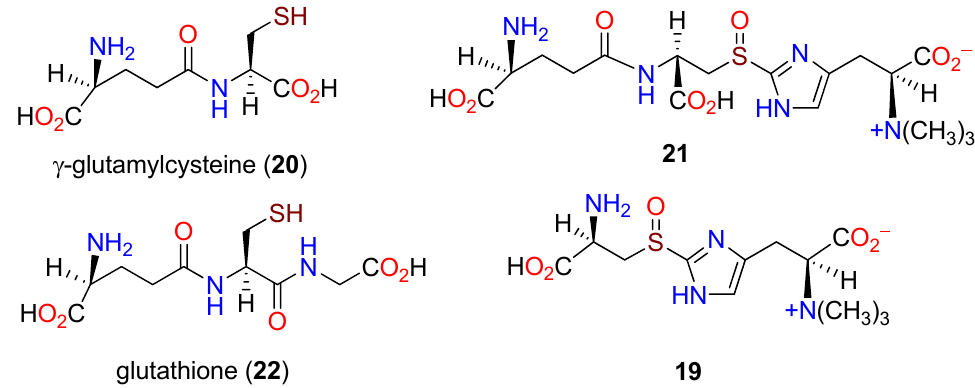
Figure 4. Structures of γ -glutamylcysteine ( 20 ), 21 , glutathione ( 22 ), and 19 .